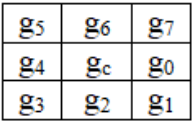
Figure 2. Neighbourhood region with g c center